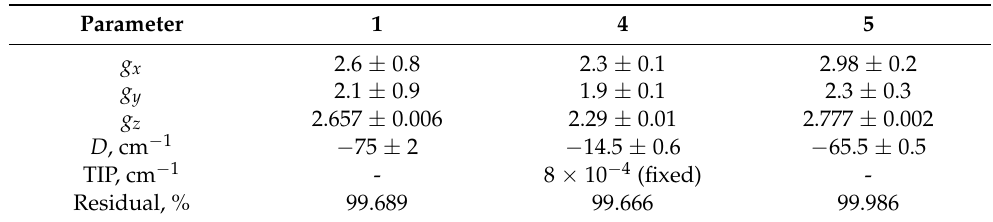
Table 1. The best-fit parameters of the χ T(T) dependences for complexes 1 , 4 , and 5, calculated using PHI